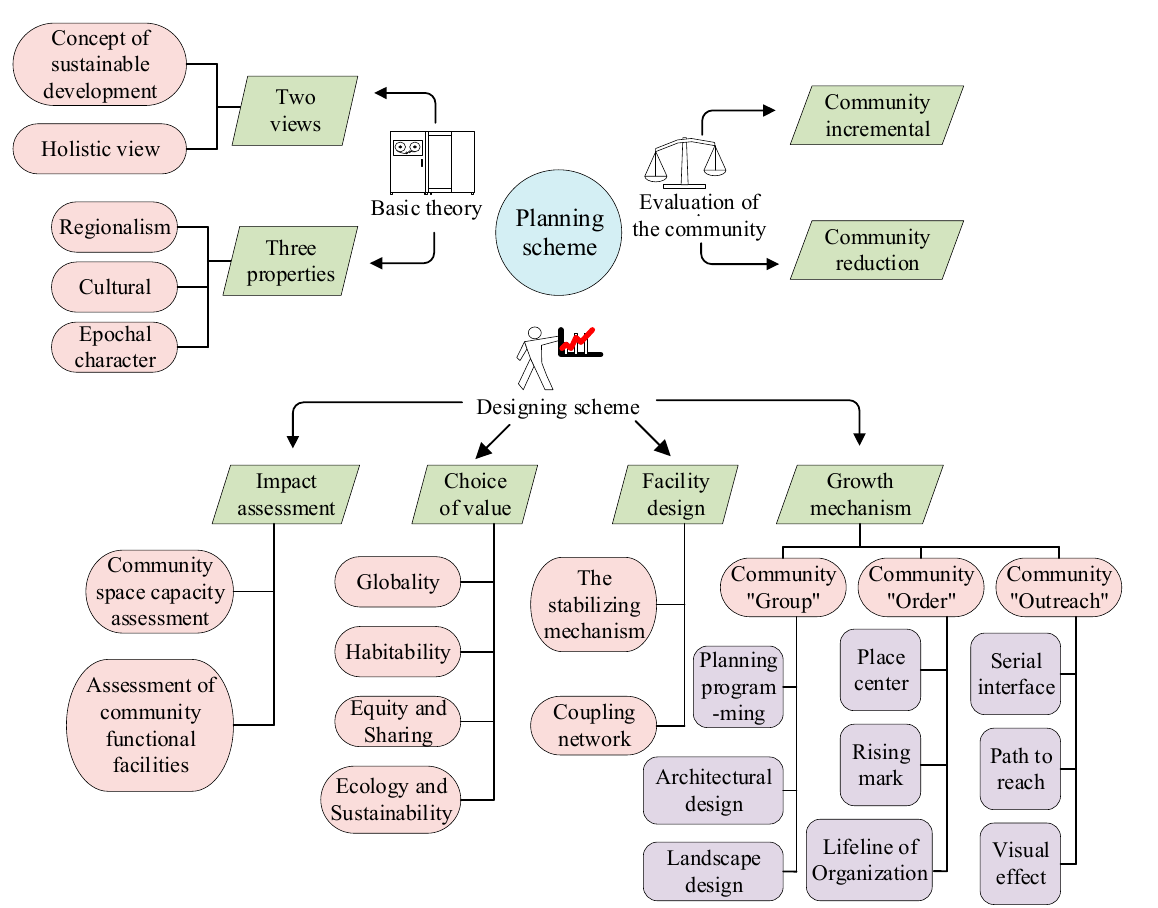
Figure 4. The healthy city community space’ specific planning process and schemes.